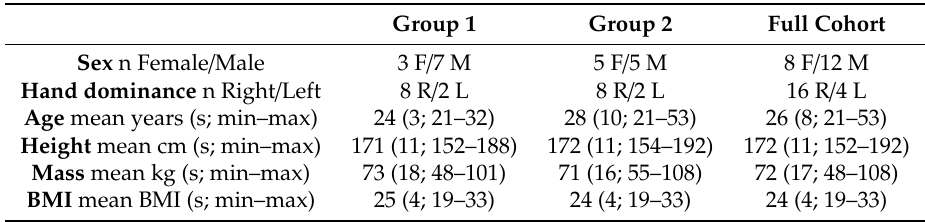
Table 3 for each group and for the full cohort. Table 2. Participant demographics.